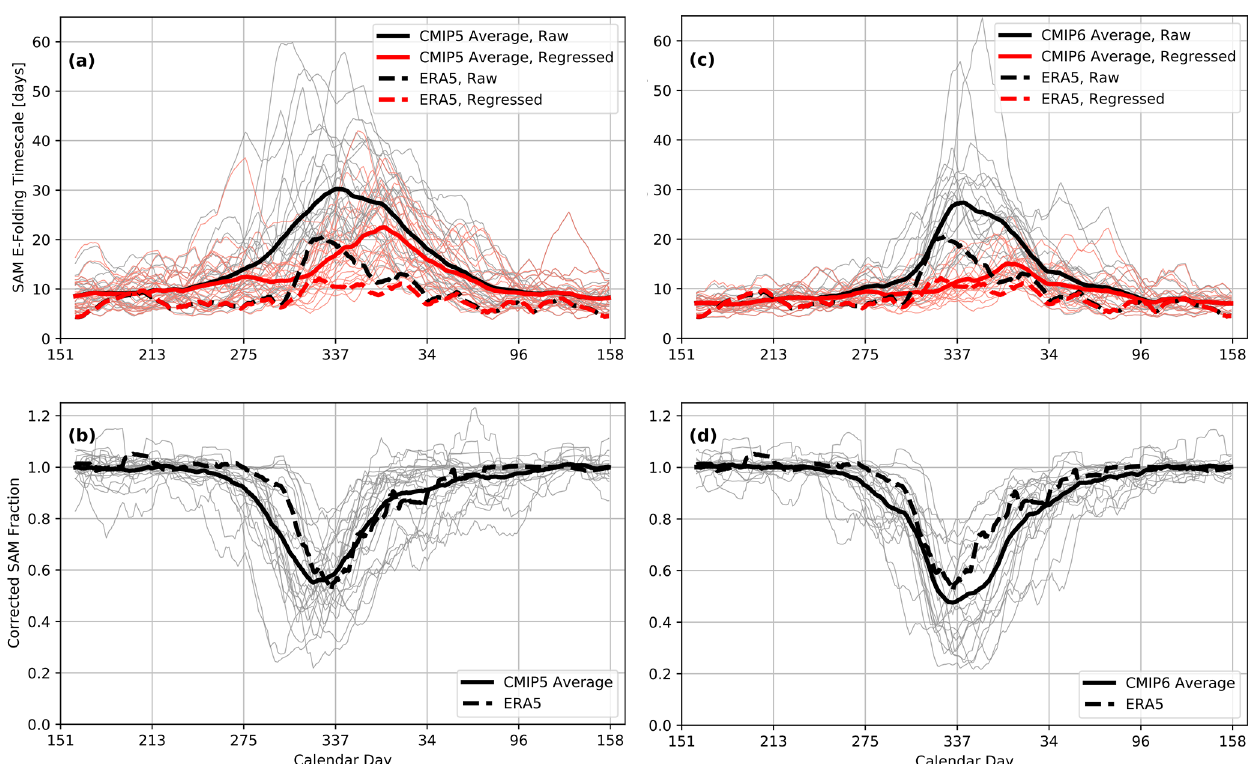
Figure 5. (a) Annual cycle of the corrected and uncorrected SAM e -folding timescale in CMIP5 simulations (black and red lines respec- tively). All results were calculated using zonally averaged zonal wind at 850hPa from the 1950–2005 historical experiments. The timescale was then averaged with a 20d running window. Thin lines represent individual models. (b) Fraction of corrected to uncorrected SAM timescale. Grey lines show the individual CMIP5 models, with the solid black line the average over all grey curves; the dashed black line shows ERA5. (c–d) Same as panels (a) – (b) but for the 1950–2013 historical CMIP6